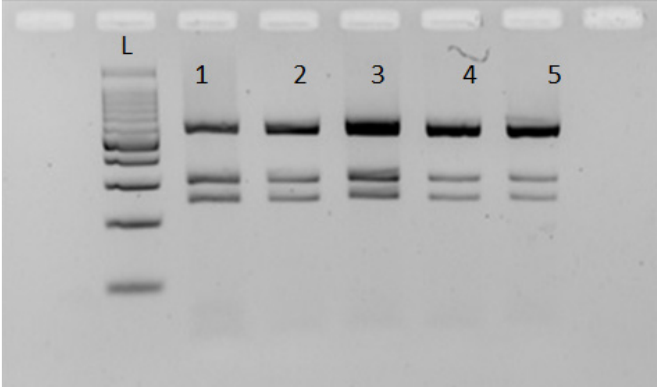
Figure 4. A representative gel displaying the Restriction Fragment Length Polymorphism profiles of C. rudolphii A obtained after digestion of rrnS amplicons with Dde I. L: molecular ladder 100 bp.